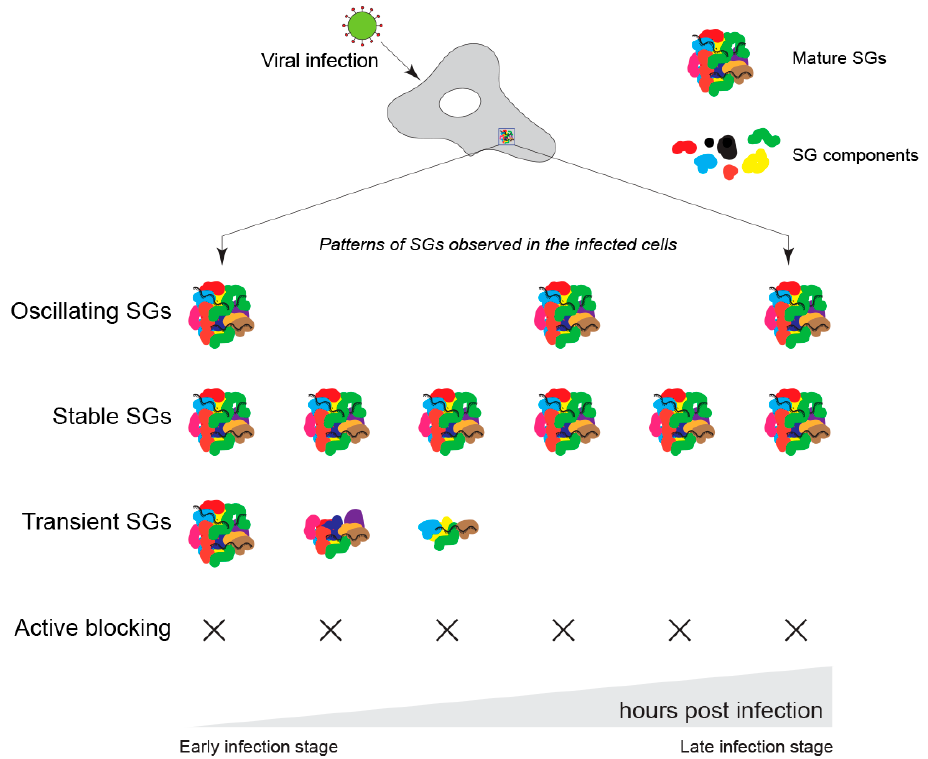
Figure 3. Patterns of SGs observed during infection by distinct viral types.